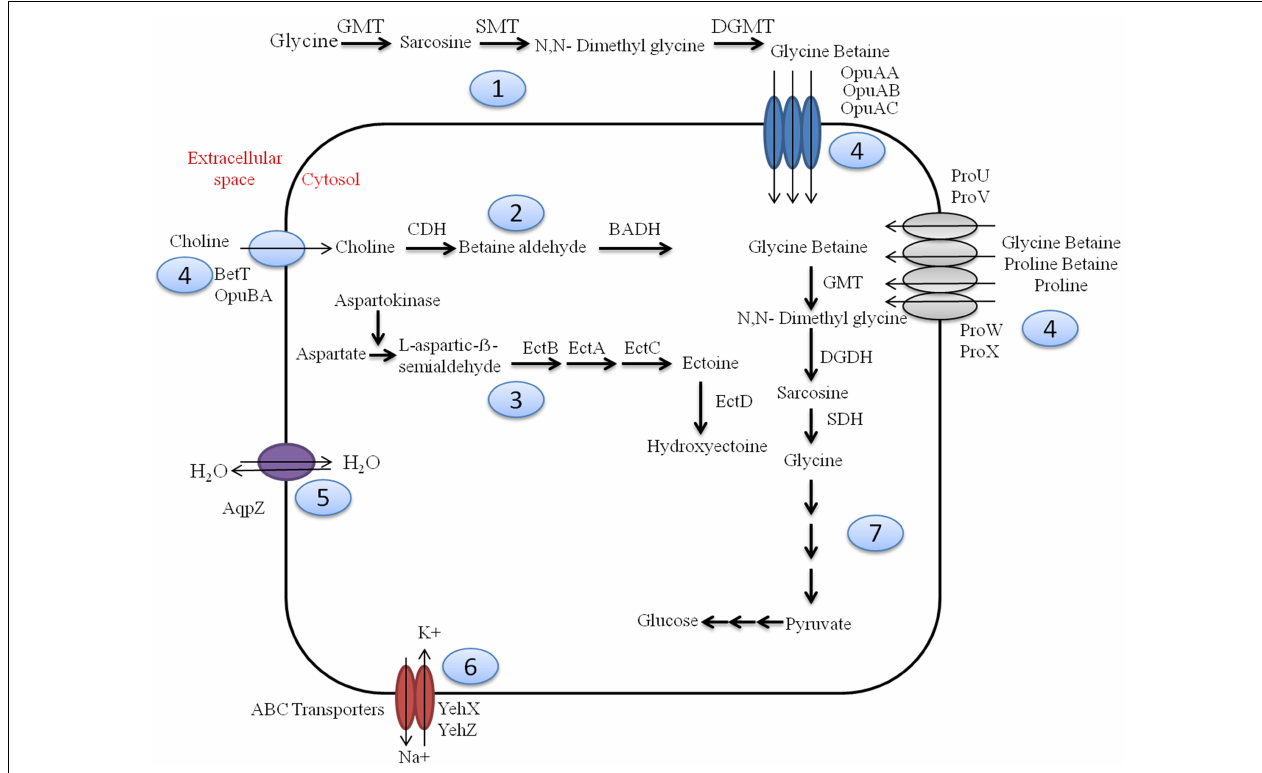
FIGURE 1 | Overview of osmotic stress tolerance mechanisms prevalent within Sambhar hypersaline lake microbiome. Sambhar salt lake microbiome has genes clusters encoding proteins for the biosynthesis of osmolytes like Glycine Betaine from glycine (1) & choline (2), Ectoine and Hydroxyectoine (3); transport of various osmolytes (proline, glycine betaine, choline, etc.) (4), water (5), ions (6); and metabolism of glycine betaine to generate energy-rich metabolic substrate (7). GMT, glycine N -methyltransferase; SMT, sarcosine N -methyltransferase; DGMT, dimethylglycine N -methyltransferase; DGDH, dimethylglycine dehydrogenase; SDH, sarcosine dehydrogenase; CDH, choline dehydrogenase; BADH, betaine aldehyde dehydrogenase; EctABCD, ectoine biosynthetic enzymes.